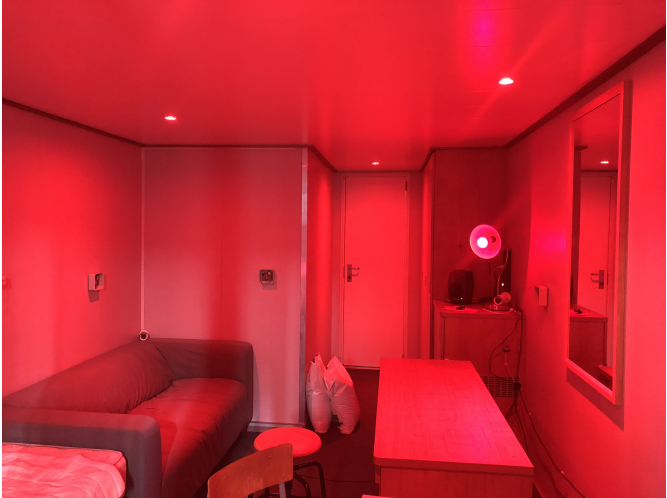
Figure 12. Demo Cabin: red light